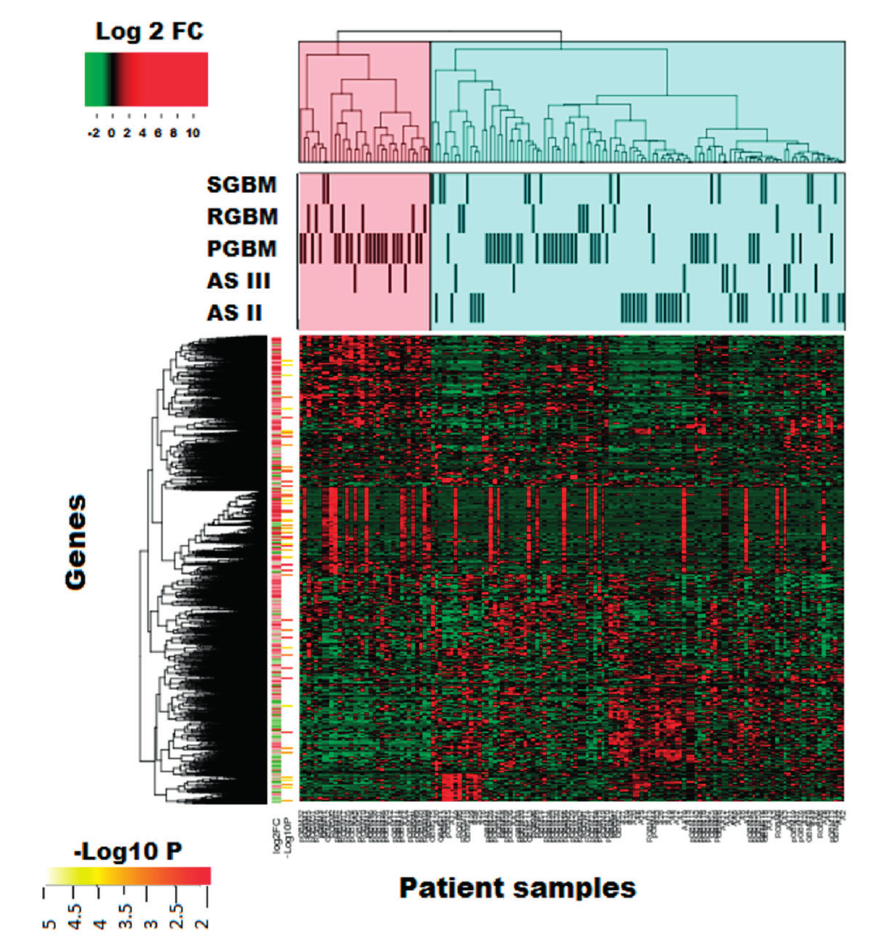
Fig. 1. Differential gene expression in AS II - IV. Heat map of differentially expressed genes in astrocytoma subtypes. Heat map of 13635 genes expressed across different subtypes showing a distinct gene expression pattern between grade II and grade IV astrocytoma samples. Shared gene expression between all grades can be seen as